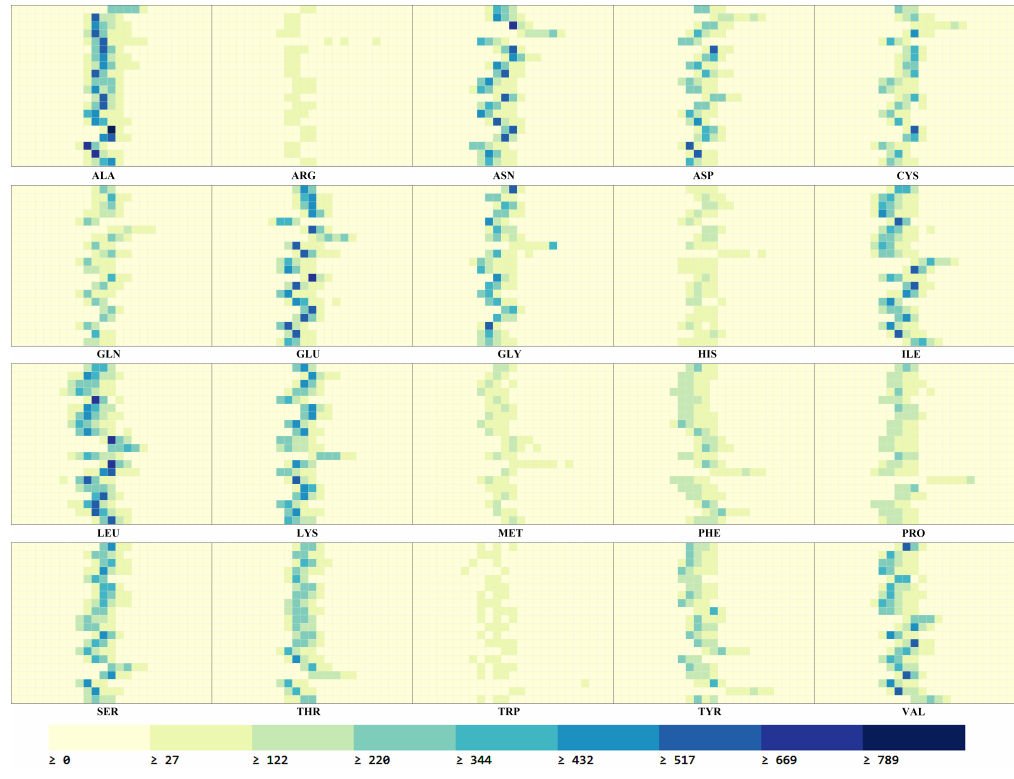
Figure 4. Feature maps of peptide chain mutation